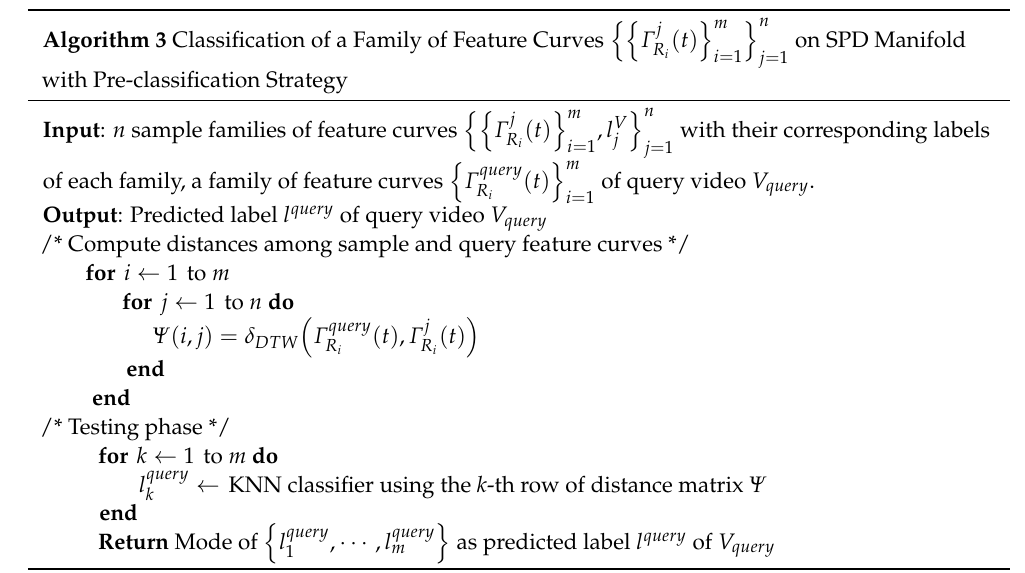
Algorithm 3 Classification of a Family of Feature Curves with Pre-classification